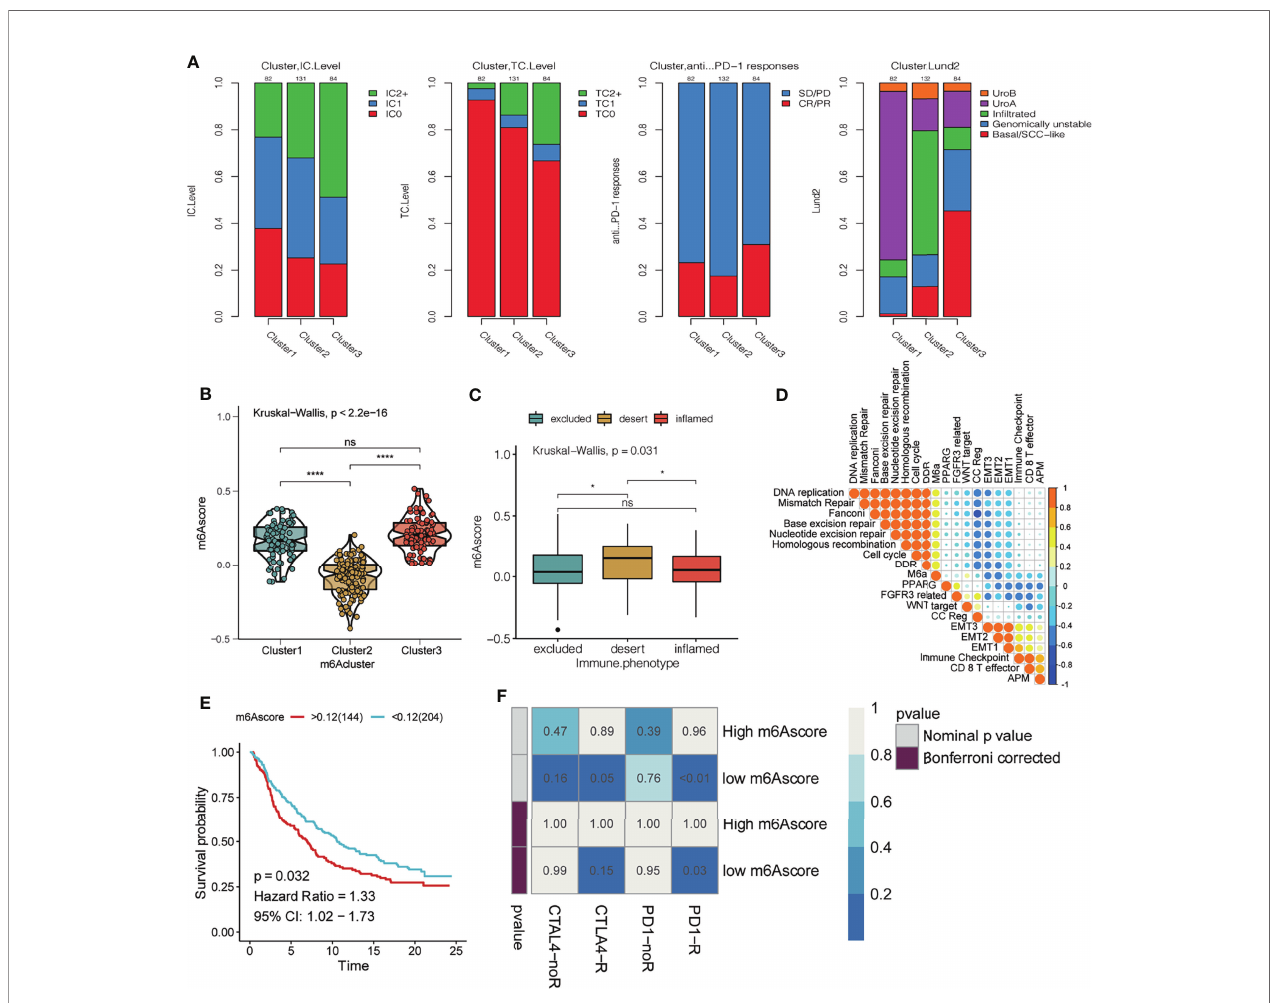
FIGURE 8 | Effect of m 6 A modi fi cation mode on the treatment of bladder cancer with PD-L1. (A) From left to right, the stacking histogram shows the relationship between the three kinds of m 6 A modi fi cation patterns and PD-L1 expression on immune cells (IC), PD-L1 expression on tumor cells (TC), response to atezolizumab, and Lund typing. (B) m 6 Ascore difference between 3 different m 6 A modi fi cation patterns. The asterisk represents the statistical p-value (*P < 0.05; ****P < 0.0001, ns P > 0.05). (C) The difference in m 6 Ascore among the three immunophenotypes; the asterisk represents the statistical p-value (*P < 0.05; ****P < 0.0001). (D) Spearman correlation was used to analyze the relationship between the m 6 Ascore and known gene characteristics in the IMvigor 210 cohort. The larger the circle, higher the correlation. (E) KM curve showing the effect of m 6 Ascore on OS in the IMvigor210 cohort. (F) Using the SubMAP algorithm, we predicted response to the anti-PD1 and anti- cytotoxic T-lymphocyte-associated protein 4 (CTLA4) immunotherapy in the groups with high and low m 6 A score. High IC score group may respond better to the PD-1 treatment (Bonferroni-corrected P =